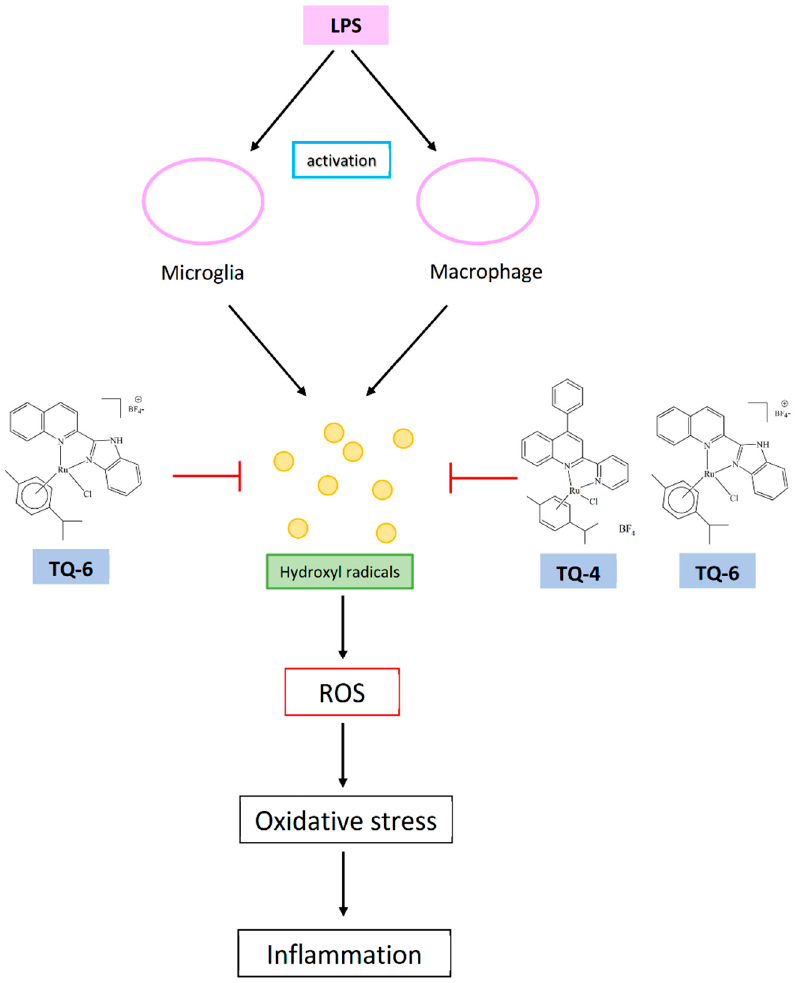
Figure 6. Ruthenium compounds TQ-4 and TQ-6 show anti-inflammatory effects via inhibiting OH• radical in LPS induced microglia/macrophages.